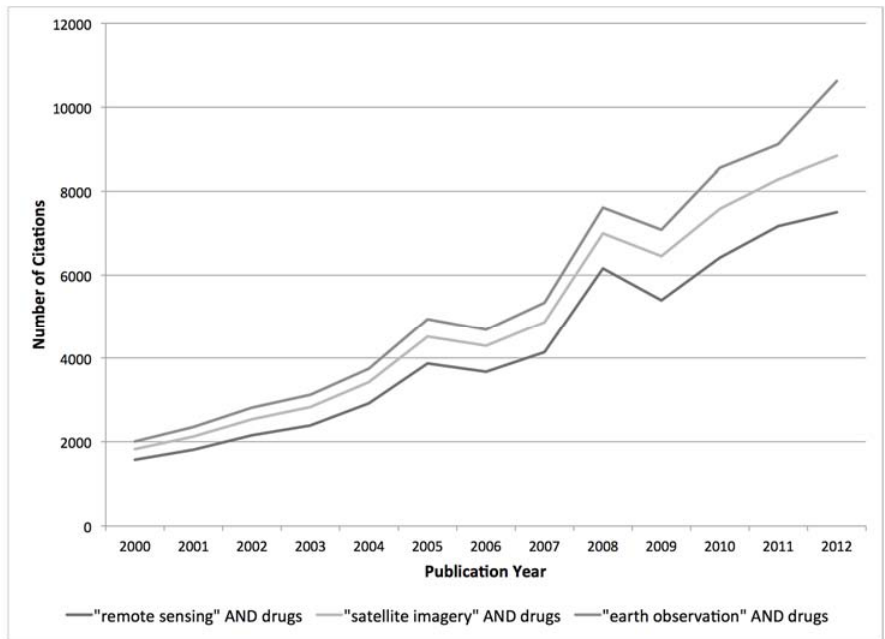
Figure 3. Results from Google Scholar searches for “drugs” and remote sensing terms,